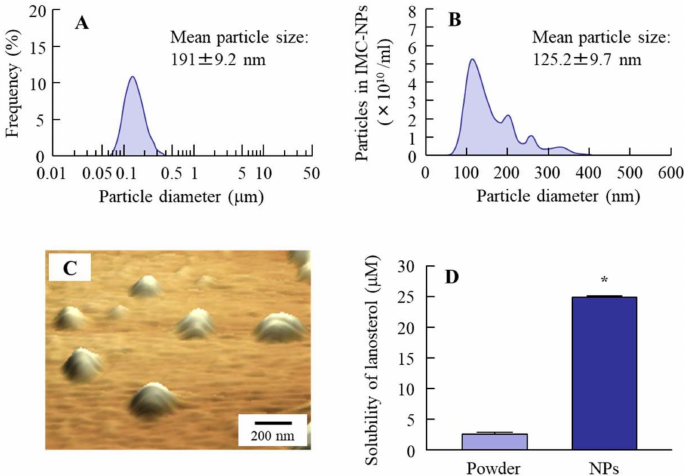
Figure 1. Particle size, atomic force microscope (AFM) image, and solubility of lanosterol